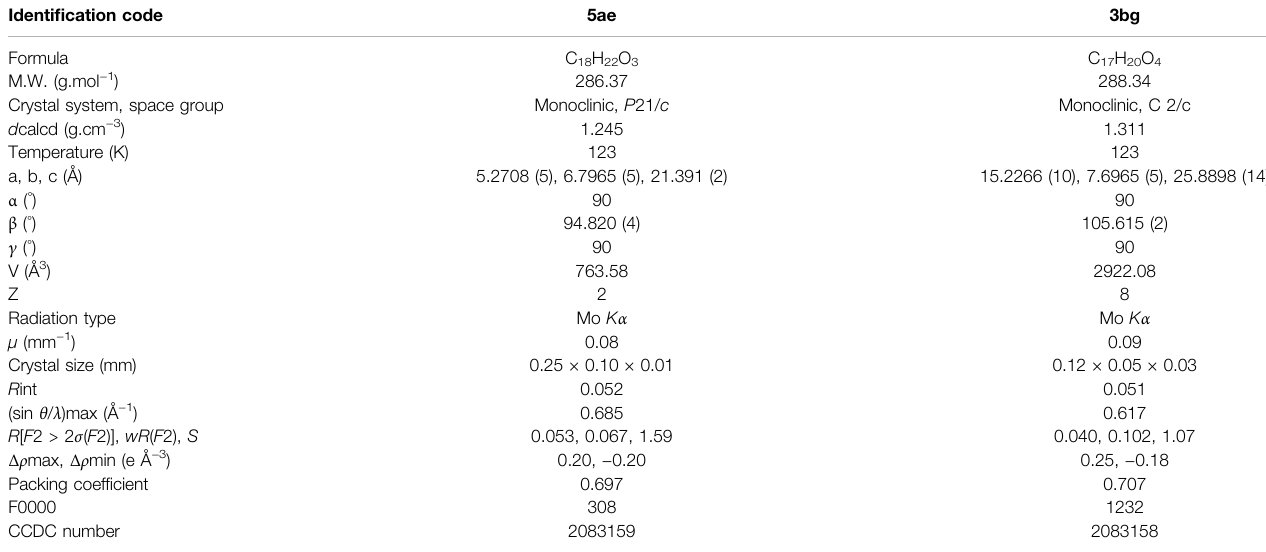
TABLE 2 | Crystal data and structure re fi nement details for 5ae and 3bg . Identi fi cation